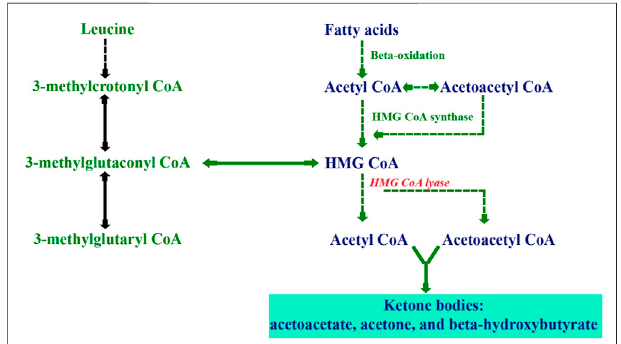
FIGURE 1 | Biochemical pathways illustrating ketogenesis through the metabolism of fatty acids and